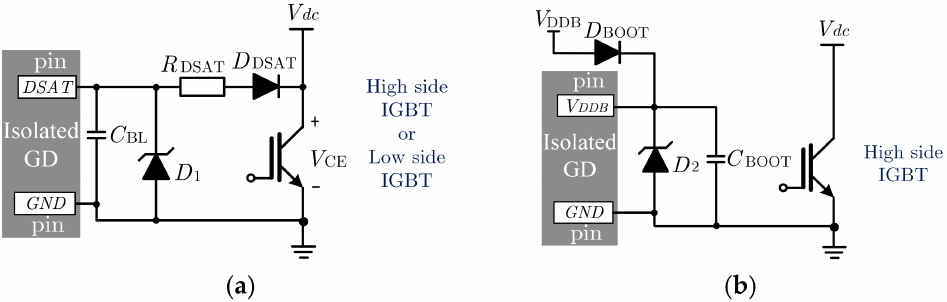
Figure 8. ( a ) Desaturation circuit; ( b )